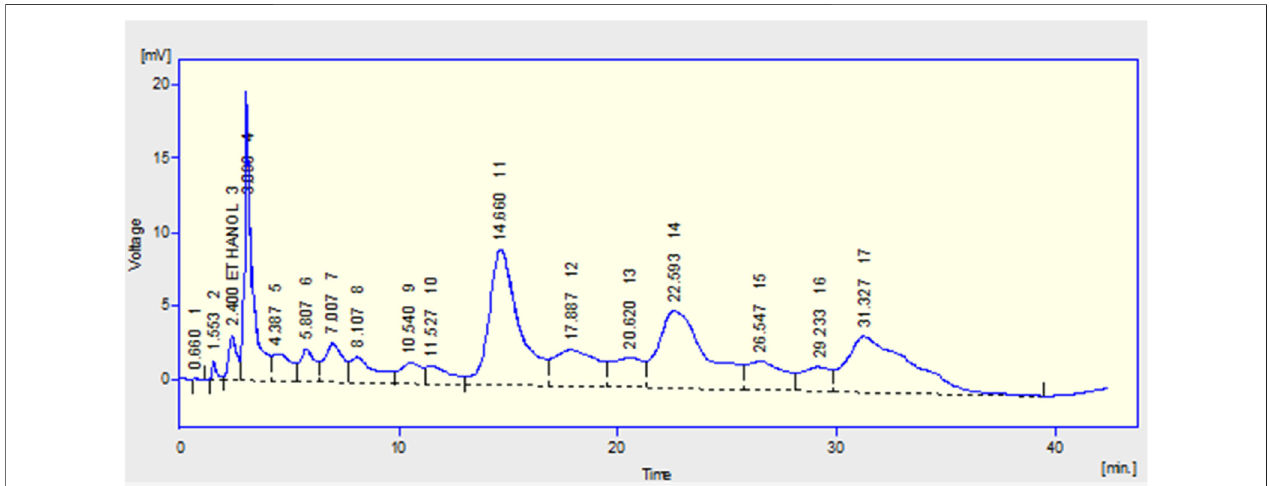
Frontiers in Energy Research |